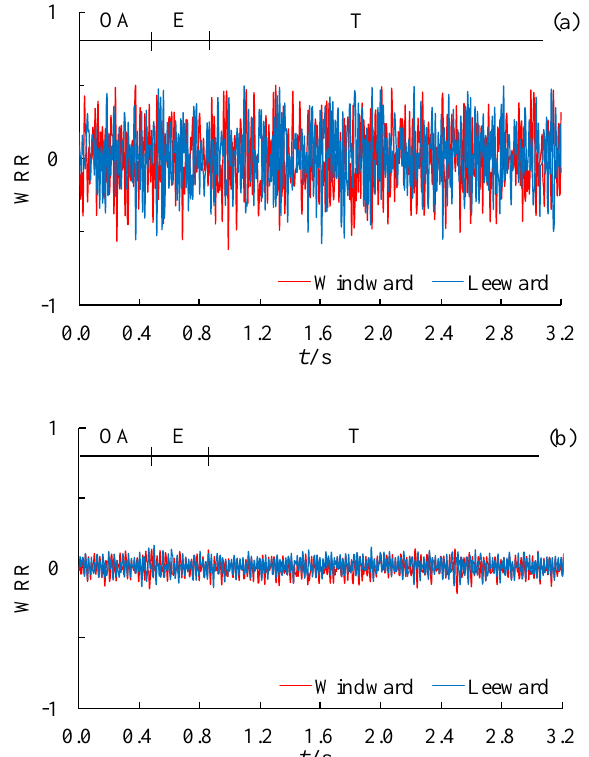
Figure 22. Time-history of the wheel load reduction rate (WRR) in the first wheelset of the head carriage under conditions of different track irregularity spectrums, ( a ) present study, ( b ) Chinese code (open air (OA); entering entrance (E); tunnel (T), train speed = 250 km/h, no crosswind).